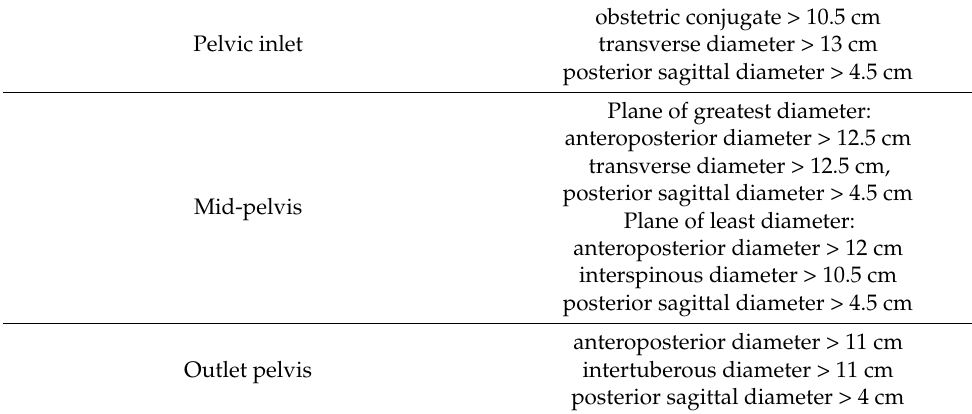
Table 2. The main diameters of the gynecoid